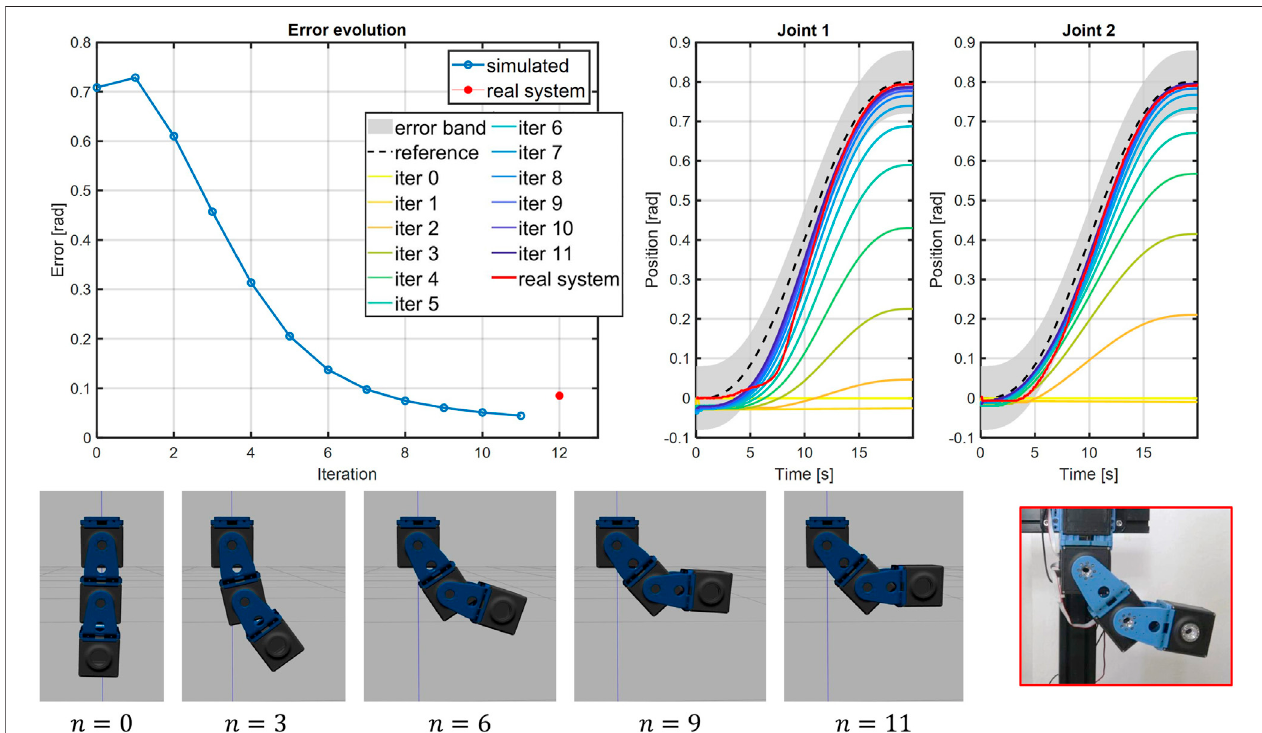
FIGURE 15 | The Iterative Learning Control (ILC) procedure is executed on the simulated platform to retrieve the desired link equilibrium positions for the joints. Then,thecontrolinputsarefeddirectlytotherealsystem.Top-leftplotshowstheevolutionoftheerror,computedasshownin Section4.3 ,throughtheiterations,while top-right illustrates the trajectory tracking for each iterations and for the real test. The bottom fi gures show the frame sequences of the learning process and of the real hardware